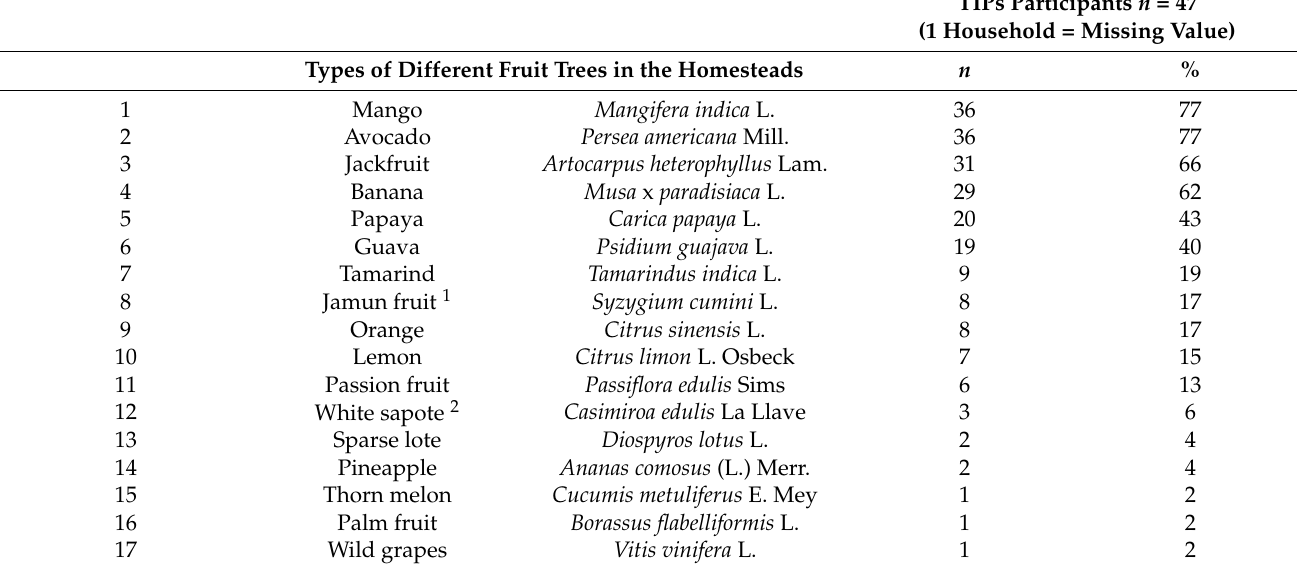
TIPs Participants n =